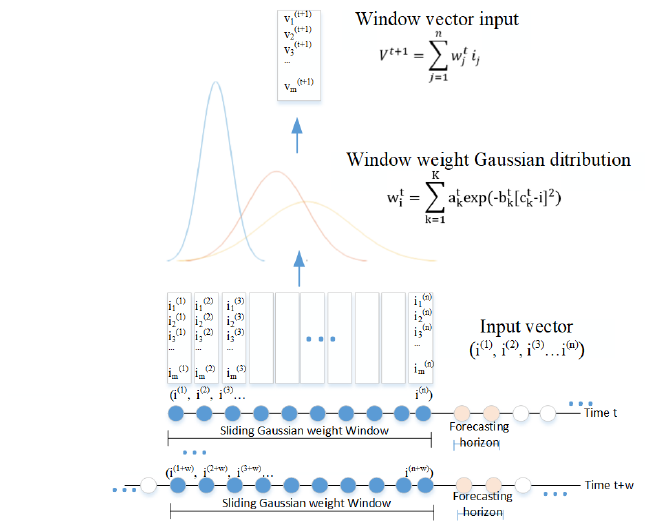
Figure 5. Gaussian sliding windows for initial weights in attention